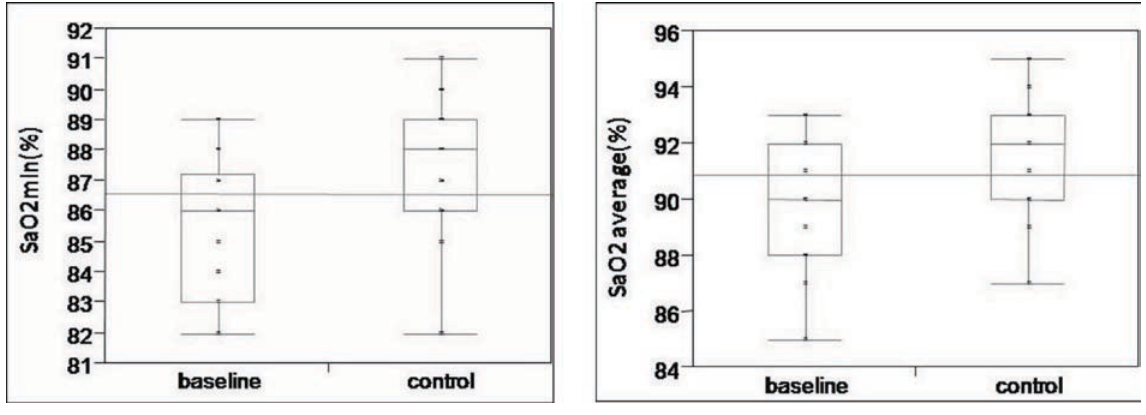
Figure 1. Effects of salmeterol